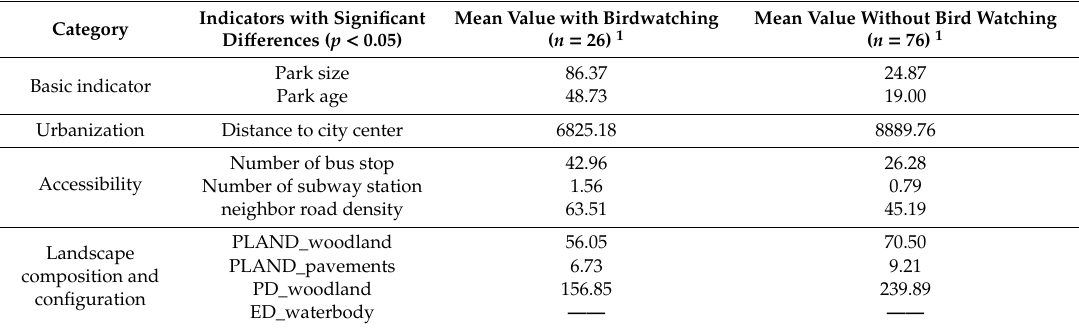
Table 3. Pairwise comparisons of parks with / without birdwatching